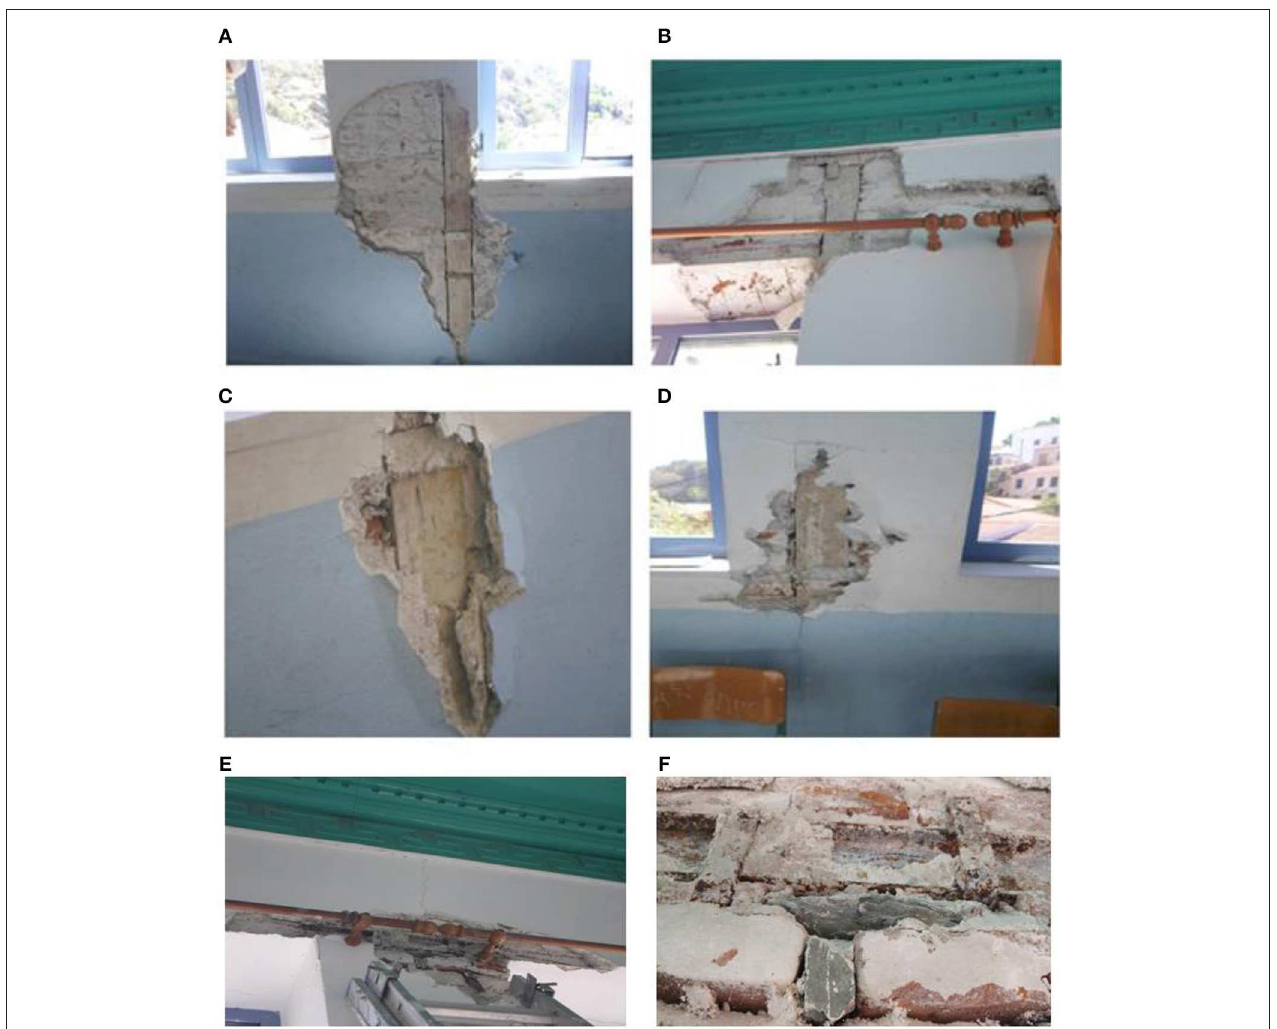
FIGURE 5 | (A–D) Damages indicating weak connections between timber frames and masonry. (E,F) Damages attributed to weak mortar and the presence of voids inside the masonry